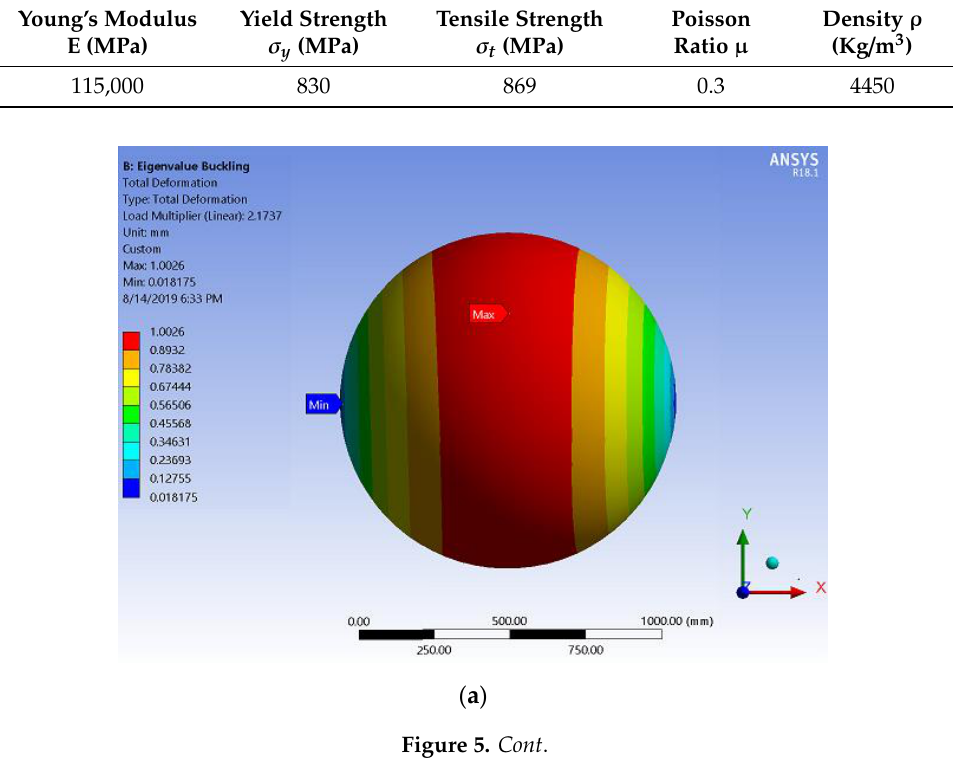
Table 2. Properties of Titanium alloy (Ti-6Al-4V).